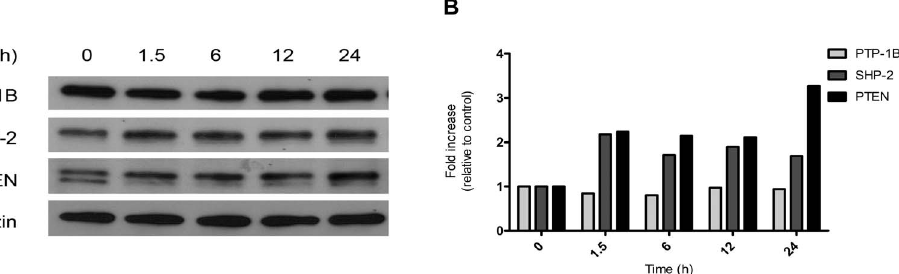
Figure 2. SHP-2 and PTEN protein expression increases during Rb/E2F-associated apoptosis. ER-dnE2F1 cells were treated with 4-OHT for the indicated times to induce Rb/E2F-associated apoptosis. Control cells (0 h) were left untreated. (A) Total protein was isolated from lysated cells at the indicated time points following induction of apoptosis, resolved by SDS-PAGE, and immunoblotted with antibodies specific for PTP-1B, SHP-2, PTEN and b -actin. (B) Relative expression levels of PTP-1B, SHP-2, and PTEN were quantified by densitometry. (h)